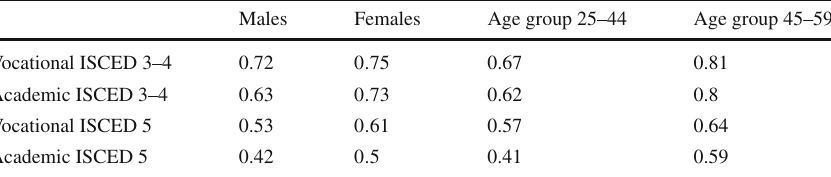
Table9 ProbabilityofbeingNEETbygender,ageandeducationtype.Rawdata. Source :Ourcomputations using PIAAC data Males Females Age group 25–44 Age group